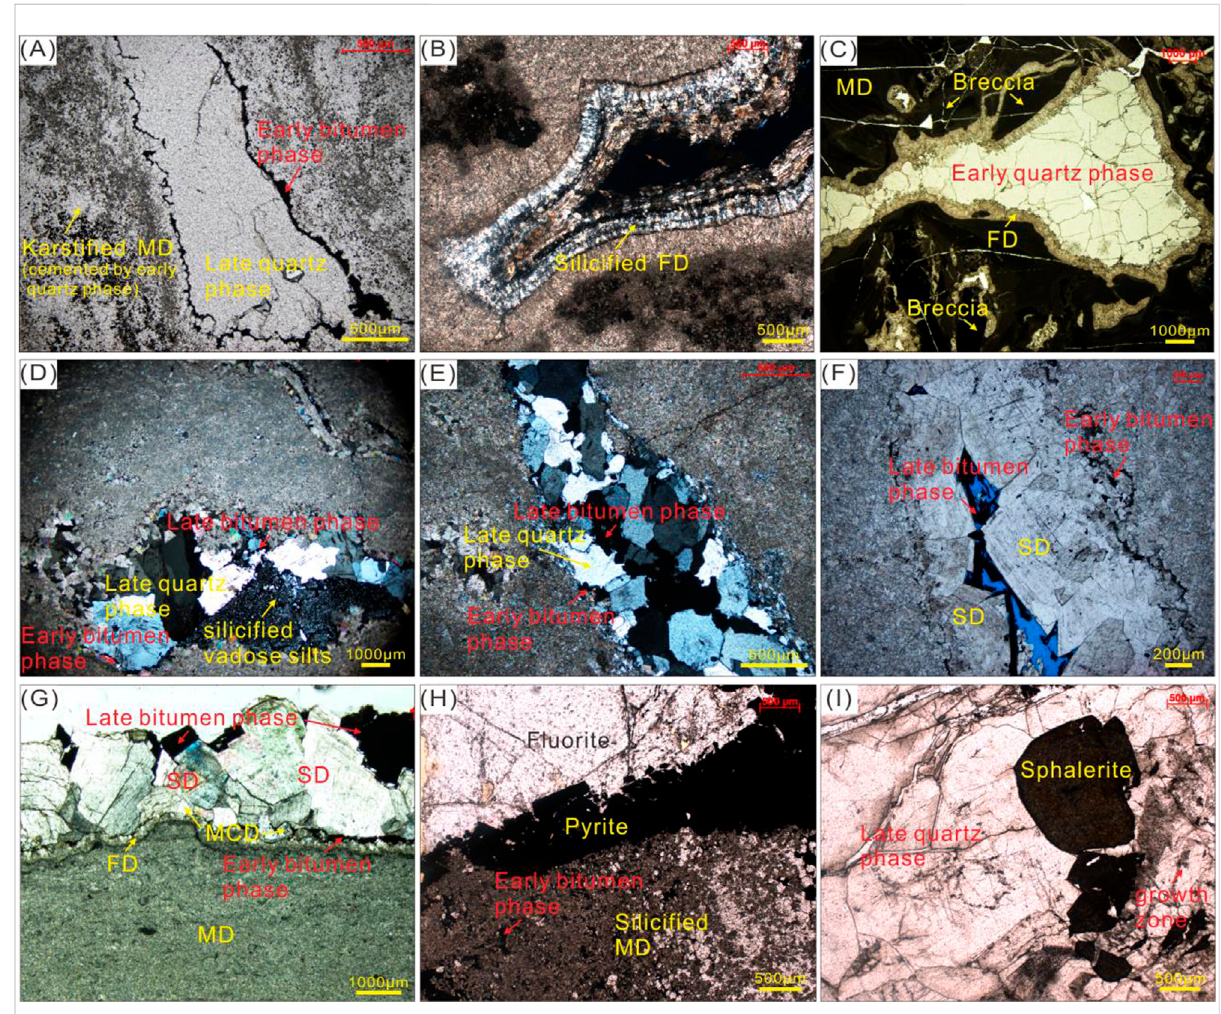
FIGURE 9 MicroscopiccharacteristicsofpetrographicrelationshipsbetweendifferentrockfabricsintheDengyingFormationofCentralSichuanBasin. (A) Karsti fi edMDcementedbyearlyquartzphaseunderPPL,WellGS18,5184.13 m – 5184.72 m. (B) Sili fi ed fi brousdolomites(FD)alonginnerwallofvugs exhibit grayish white under XPL, Well GS102, 5094.66 m. (C) Fibrous dolomites (FD) predating early quartz phase fi lled along inner wall of vugs formed in epidiagenetic stage, Well MX108, 5304.5 m. (D) Vadose silts formed during epidiagenetic stage are silici fi ed by hydrothermal fl iuds, Well GS102, 5045.53 m. (E) Late quartz phase between two-stage bitumen phase, Well GS102, 5102.89 m. (F) Saddle dolomite (SD) between two- stage bitumen phase, Well GS1, 4985 m (Jiang et al., 2016). (G) Saddle dolomite (SD) predating fi brous dolomites (FD) and early bitumen phase, Well GS18, 5177.82 m. (H) Silici fi ed matrix dolomite (MD) predate early bitumen phase and MVT minerals (pyrite and fl uorite), Well MX51, 5383.48 m. (I) Coexisting relationship between sphalerite and late quartz phase characterized by growth zone, Well GS109, 5317.4